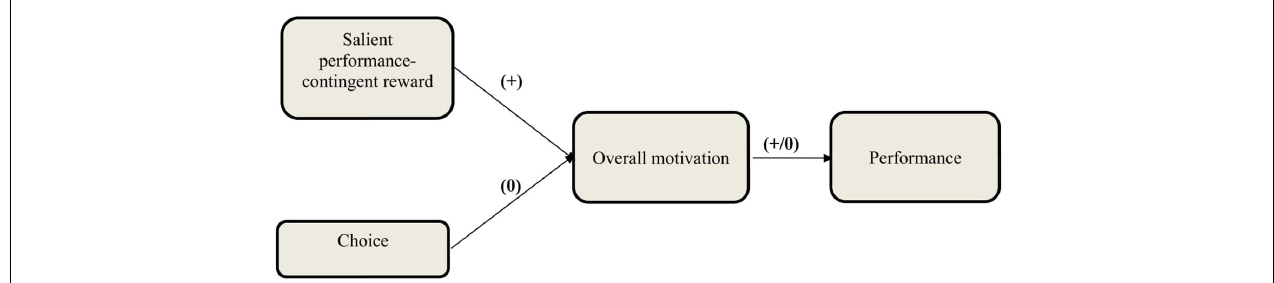
FIGURE 1 | Effect of reward salience and choice on overall motivation and performance in a controlling